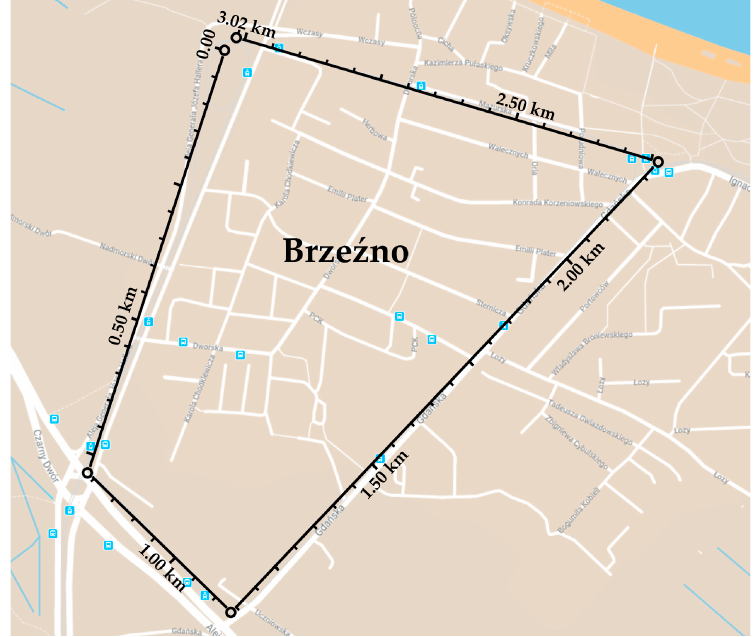
Figure 2. The route of the satellite measurement at night on 28 November 2018–29 November 2018 described in [26].